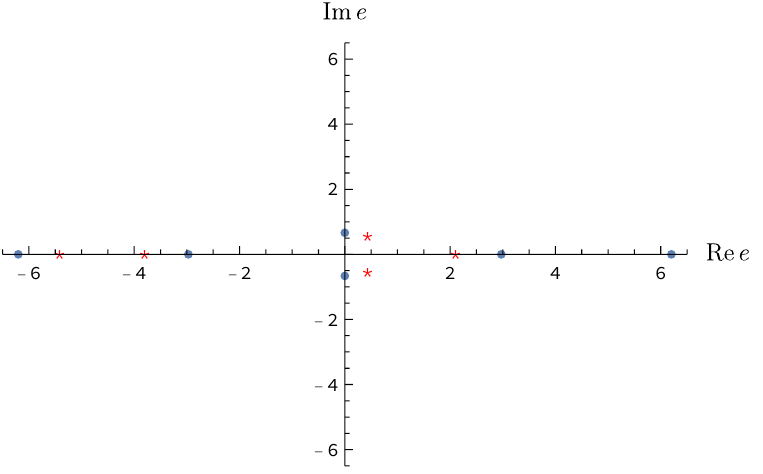
Figure 18 . Critical points of the Kepler’s curve (C.4) in the complex eccentricity plane. The blue dots are the critical points at (cid:28) = (cid:25)= 2. The points closest to the origin are located at e (cid:25) (cid:6) 0 : 662743 i . They determine the radius of convergence e L of the series (C.5). For (cid:28) < (cid:25)= 2, the critical points are located at a larger distance from the origin. For example, the critical points at (cid:28) = (cid:25)= 4 are shown by red asterisks. They determine the radius of convergence e c ( (cid:28) ), shown in the right panel of (cid:12)gure 17. With (cid:28) ! 0, the three critical points merge at e =